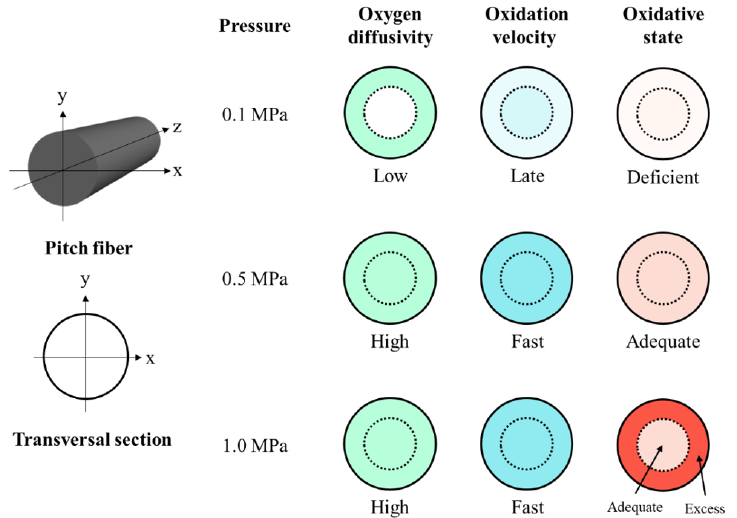
Figure 8. Schematic model pictures of the oxidation and oxidation decomposition in the oxidation–stabilization at 270 ◦ C for soaking for 0 min with a heating rate of 2.0 ◦ C / min under air flow pressures at the atmospheric level (0.1, 0.5, and 1.0 MPa). Table 4. Estimated oxidation state of the stabilized fiber under various air flow pressures based on the model mechanisms of oxidation di ff usion and reaction. Oxidation Reaction and Stabilization Conditions* Oxygen Oxidized State on Molecules of Di ff usivity From Mesophase Pitch Outer Surface to Center Part of Pitch Fiber